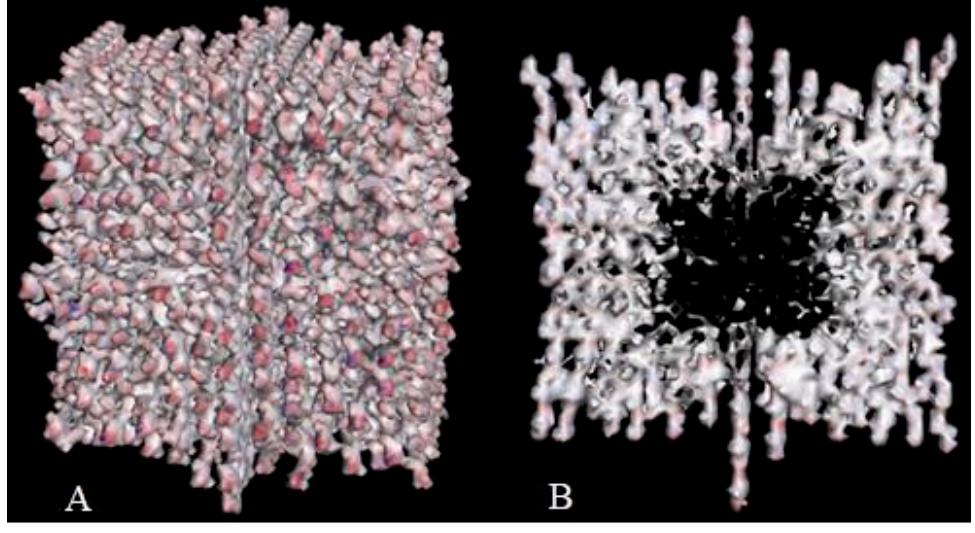
Figure 7. The view of taxifolin nanoparticle ( A ) and its cross-section ( B )